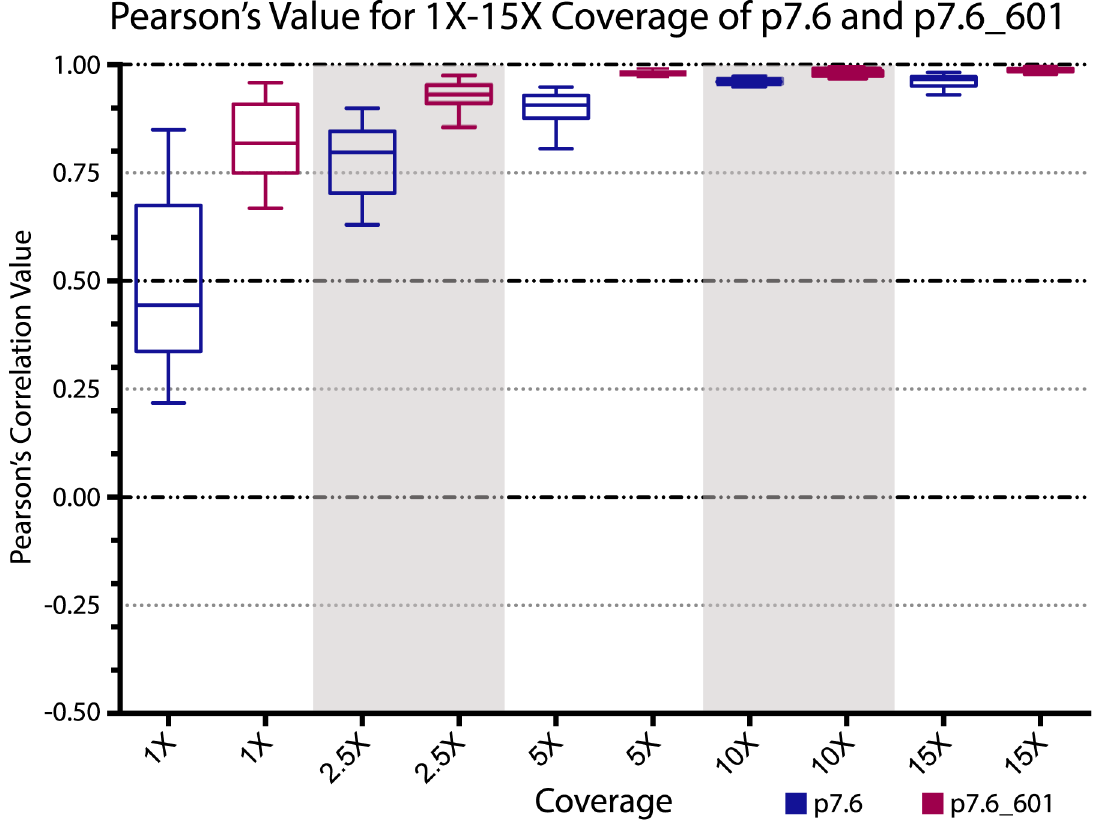
Figure 8. Higher degree of correlation between coverage of p7.6_601 compared to coverage of p7.6. Range of correlation values for coverage levels 1X, 2.5X, 5X, 10X and 15X are displayed as a whisker plot. The correlation values from the pair-wise comparisons of the six replicates for plasmid p7.6 and the six replicates for plasmid p.7.6_601 are displayed as blue whisker boxes and purple whisker boxes respectively. The Pearson’s correlation values are on the y-axis and the coverage levels are on the x-axis.